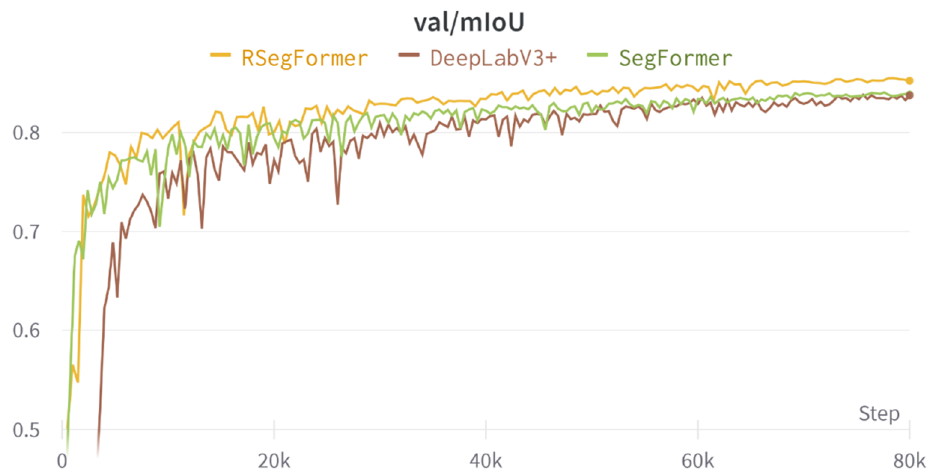
Figure 6. MIoU validation curves for different models.